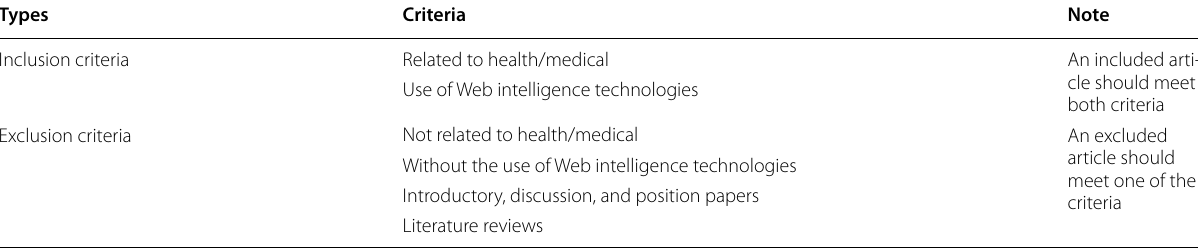
Table 1 Inclusion and exclusion